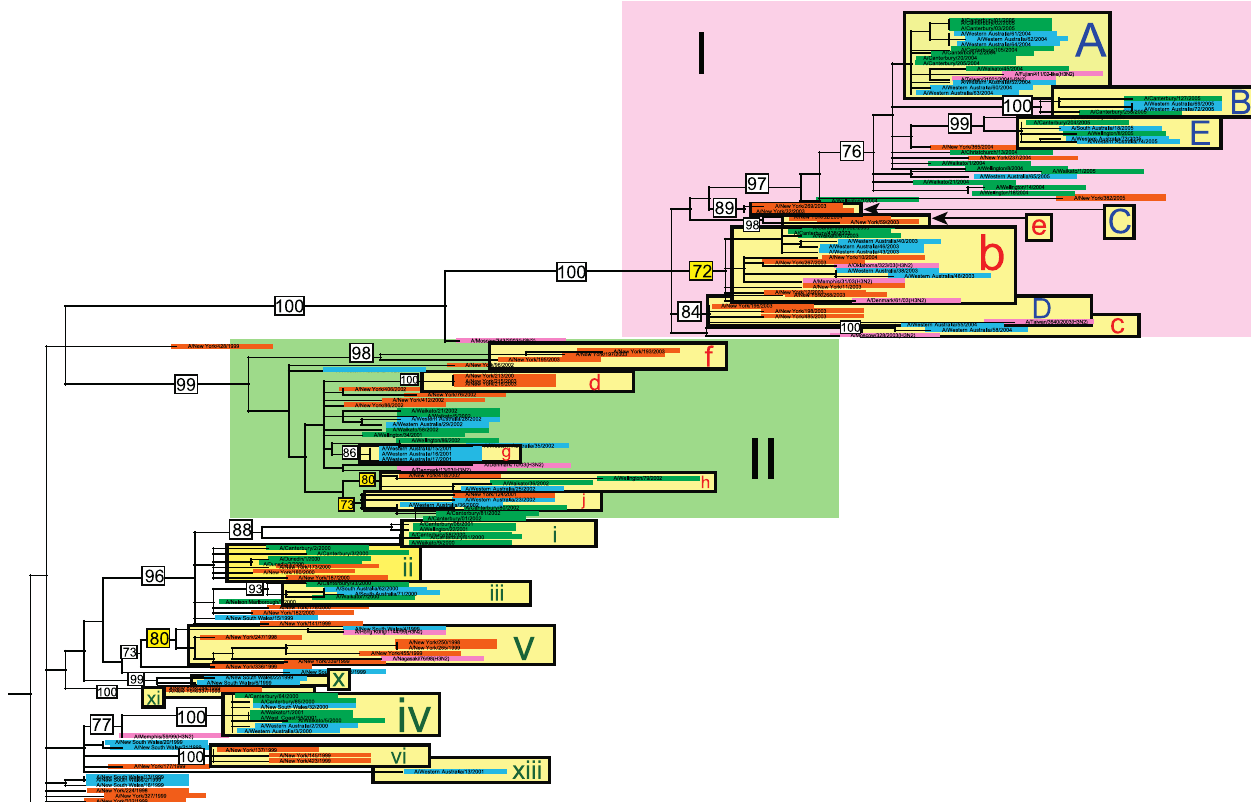
Figure 3. Phylogenetic Relationships of the HA Gene of A/H3N2 Influenza Viruses Sampled from New York State ( n ¼ 52), New Zealand ( n ¼ 51), Australia ( n ¼ 45), and Globally ( n ¼ 13) from 1998 to 2005, Estimated Using ML Color scheme, rooting, scale, and symbols are the same as those used in Figure 2.